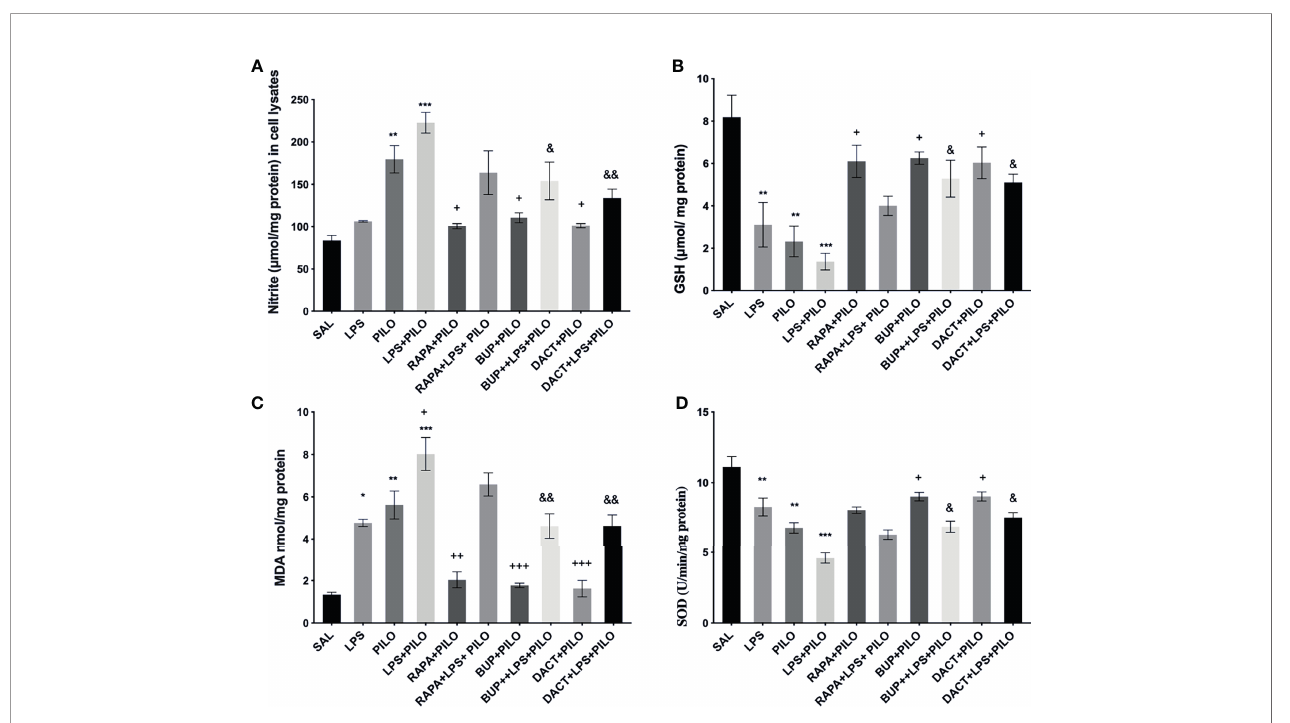
FIGURE 3 | Effects of RAPA, BUP, and DACT onPILOversusLPS+PILO-inducedHT-22 cells on (A) nitrite, (B) GSH, (C) MDA, and (D) SODlevels. Data are represented as mean ± SEM (n= 6)and analyzed byTukey Kramer multiplecomparison tests. The signi fi cance is ascertained as ***p < 0.001 versus SAL, **p < 0.01 versus SAL, *p < 0.05 versus SAL, +++ p < 0.01 versus PILO, ++ p<0.01 versus PILO, + p < 0.05 versus PILO, && p < 0.01 versus LPS+PILO, and & p < 0.05 versus